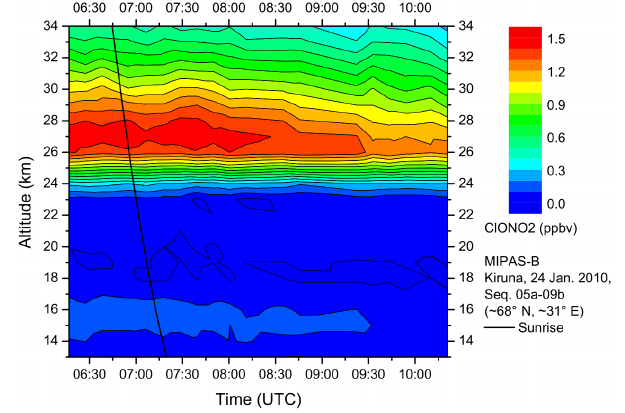
Figure 8. ClONO 2 volume mixing ratios measured with MIPAS- B during sunrise on 24 January 2010 above northern Scandinavia within the polar vortex. Figure taken from Wetzel et al. (2012, their Fig. 8) under CC Attribution 3.0